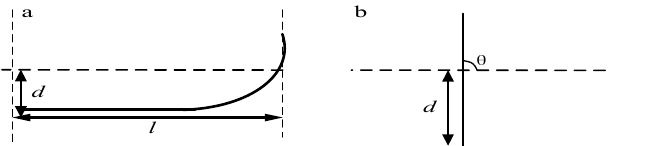
Figure 17. Evaluation index of sweet potato transplanting. ( a ) Horizontal transplanting; ( b ) vertical transplanting.